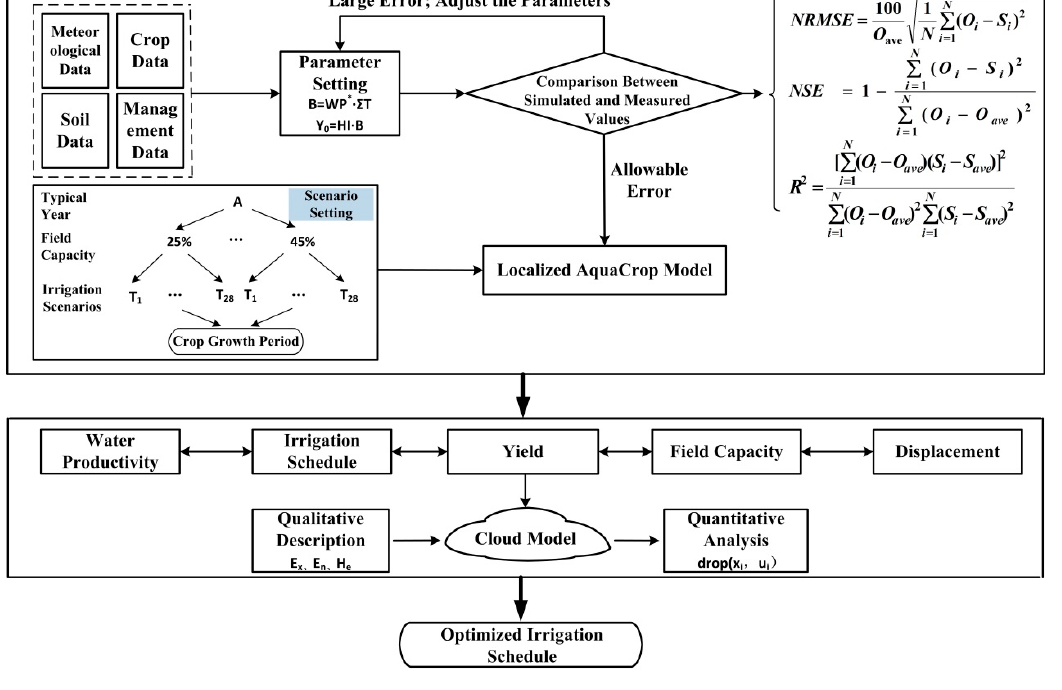
Figure 2. Study Figure 2. Study process.